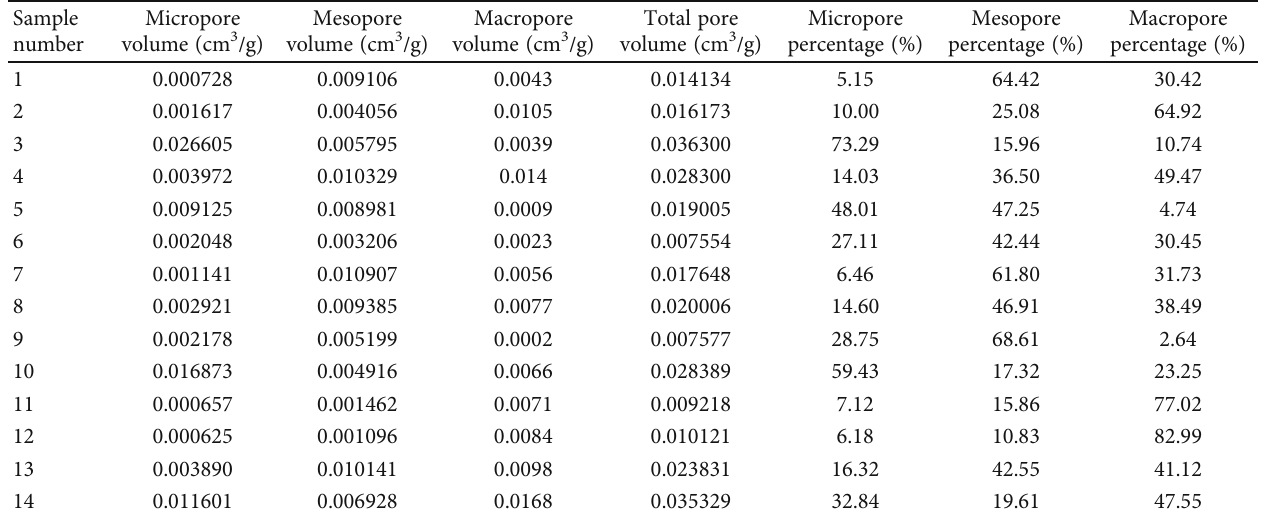
Table 4: Micropore, mesopore, and macropore volume results of N adsorption and high-pressure mercury injection. The total pore volume 2 by combining N2GA and HPMI. The micropore volume and mesopore volume are from N2GA experiment results. The macropore volume is from HPMI experiment results. The total pore volume = V mic + V mes + V mac .